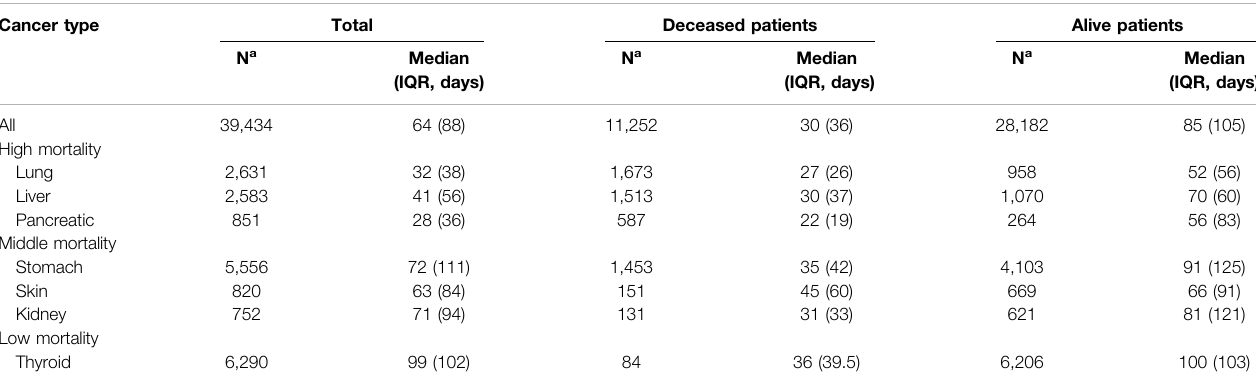
TABLE 3 | The maximum intervals between medical institution visits of patients with cancer. Cancer type